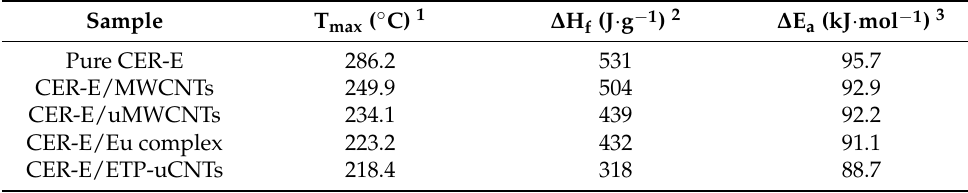
Table 2. Polymerization process (DSC data, Figure 3c) for pure CER-E, CER-E/MWCNTs, CER- E/uMWCNTs, CER-E/Eu complex (ETP) and CER-E/ETP-uCNTs. Sample T max ( ◦ C) 1 Pure CER-E 286.2 531 95.7 CER-E/MWCNTs 249.9 504 92.9 CER-E/uMWCNTs 234.1 92.2 CER-E/Eu complex 223.2 CER-E/ETP-uCNTs